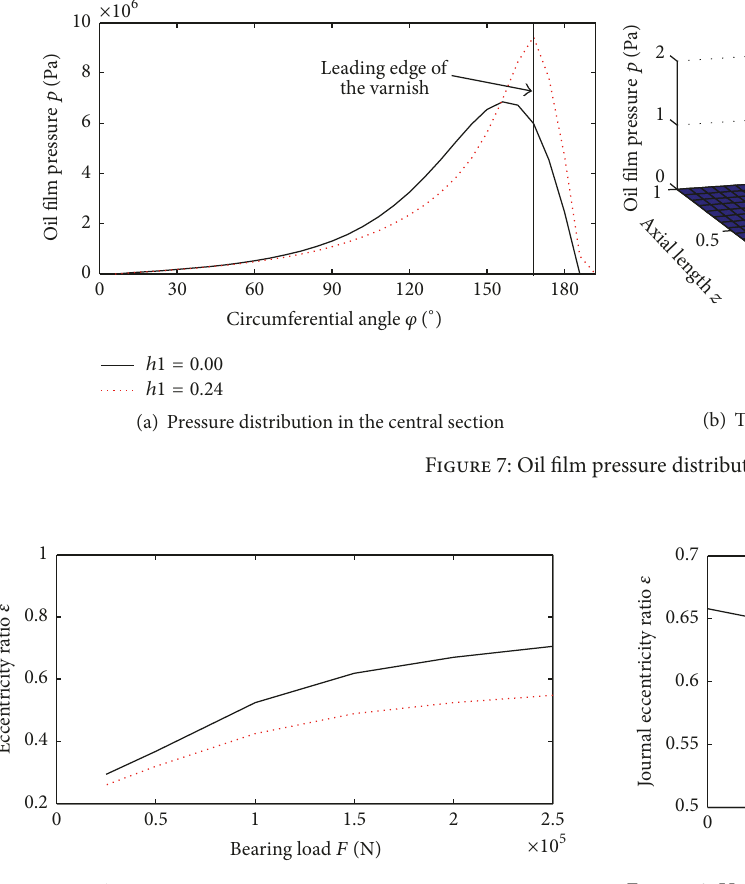
Figure 9: Variation of journal eccentricity ratio with varnish thick- ness. Table 2: Bearing equivalent stiffness and critical whirl